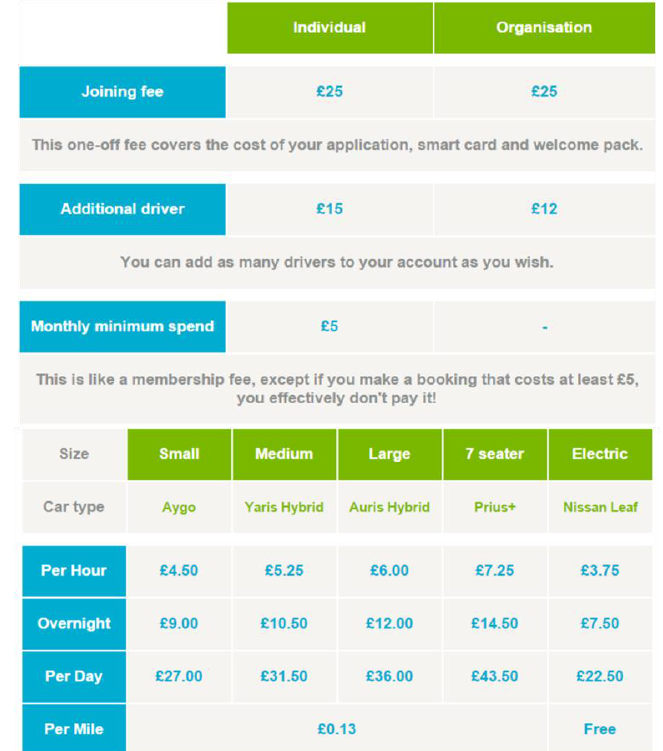
Figure 8. Cost structure for Co-wheels. Source: Co-wheels